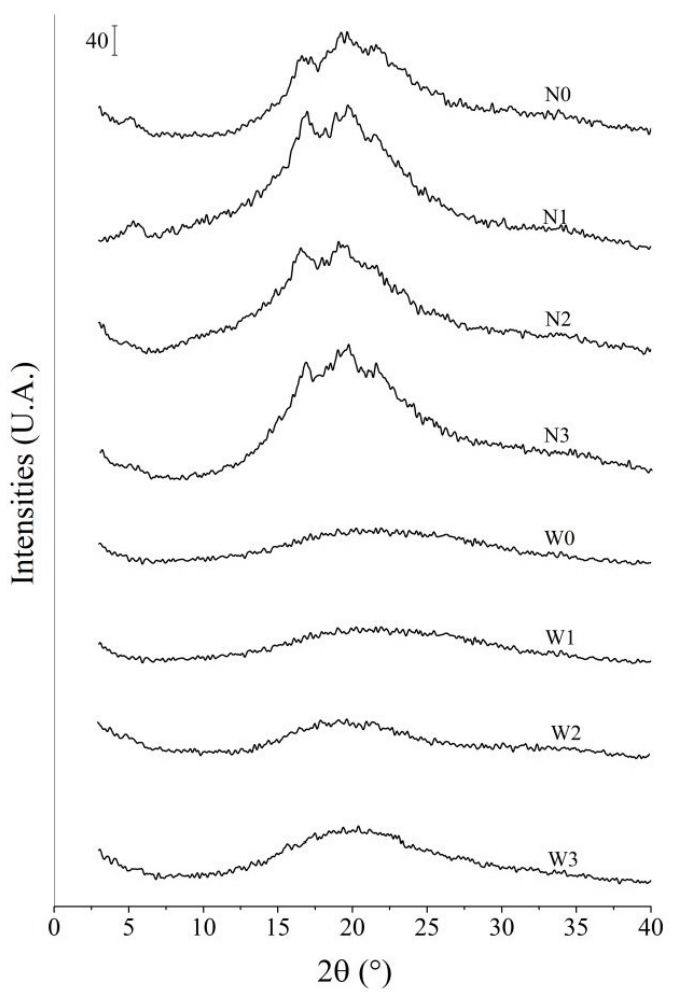
Figure 4. X-ray diffractograms of starch samples and films. Note: N0 = regular starch film with 0% nanocellulose; N1 = regular starch film with 0.5% nanocellulose; N2 = regular starch film with 1% nanocellulose; N3 = regular starch film with 1.5% nanocellulose, W0 = waxy starch film with 0% nanocellulose; W1 = waxy starch film with 0.5% nanocellulose; W2 = waxy starch film with 1% nanocellulose; W3 = waxy starch film with 1.5%